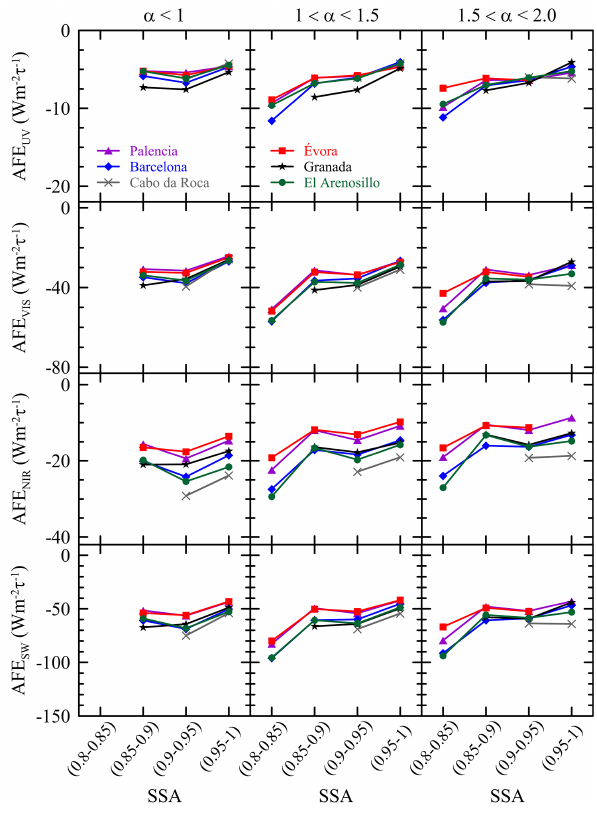
Figure 8. AFE UV , AFE VIS , AFE NIR , and AFE SW against four groups of aerosol single scattering albedo and three intervals of α at the six sites: Barcelona (blue diamonds), Palencia (purple trian- gles), Évora (red squares), Cabo da Roca (grey crosses), Granada (black stars), and El Arenosillo (green